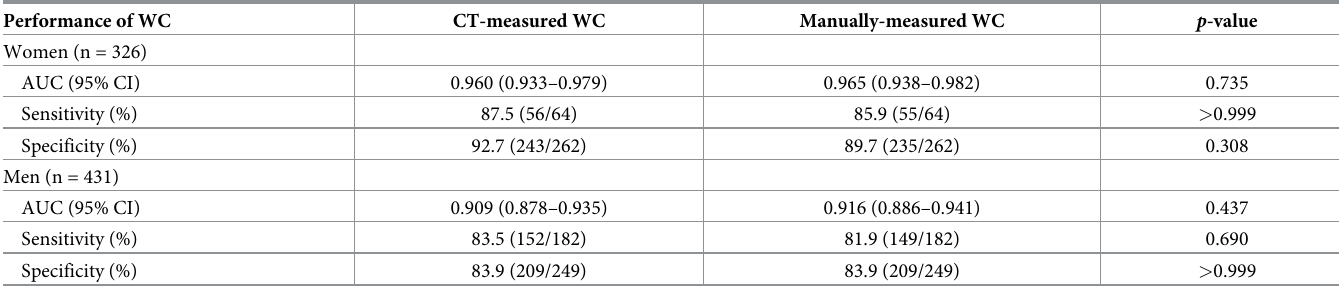
Table 2. Comparison of the performance of CT-measured and manually-measured weight circumference to identify overweight and obesity.